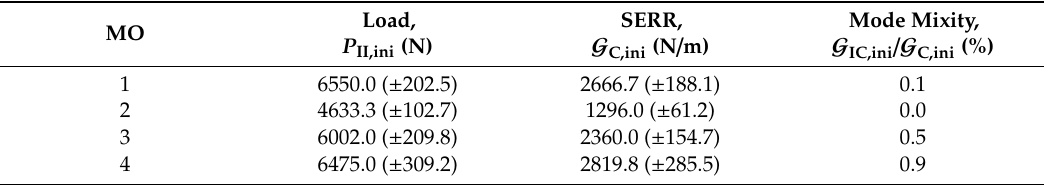
Table 6. Total strain energy release rate (SERR) ( G C,ini ) and mode mixity ( G IC,ini / G C,ini ) values of the end-notched flexure (ENF) tests, for the four manufacturing options (MOs). Load, SERR, Mode Mixity, MO / m) / G G G P II,ini (N) C,ini (N IC,ini C,ini (%) 1 6550.0 ( ± 202.5) 2666.7 ( ± 188.1) 0.1 2 4633.3 ( ± 102.7) 1296.0 ( ± 61.2) 0.0 6002.0 ( ± 209.8) 2360.0 ( ± 154.7) 0.5 6475.0 ( ± 309.2) 2819.8 ( ± 285.5) 0.9 MO: manufacturing option; SERR: strain energy release